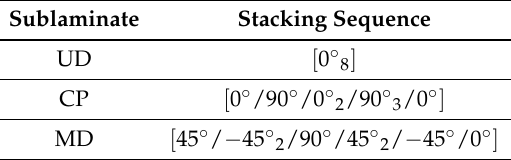
Table 2. Sublaminate stacking